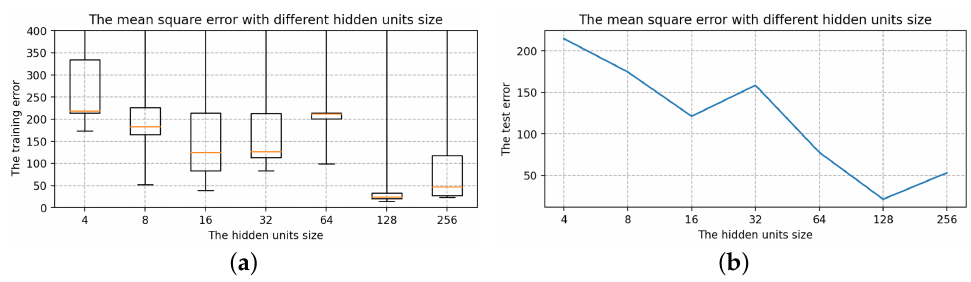
Figure 15. The mean square error with different hidden units size. ( a ) The training error with different hidden units size. ( b ) The test error with different hidden units